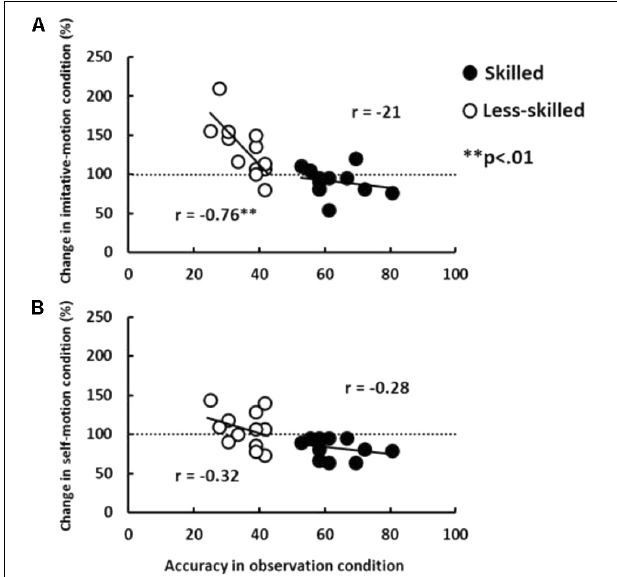
FIGURE 3 | Relationship between the change in prediction accuracy from observation condition to imitative-motion and self-motion conditions, and prediction accuracy in the observation condition. ∗ p < 0.05, ∗∗ p <